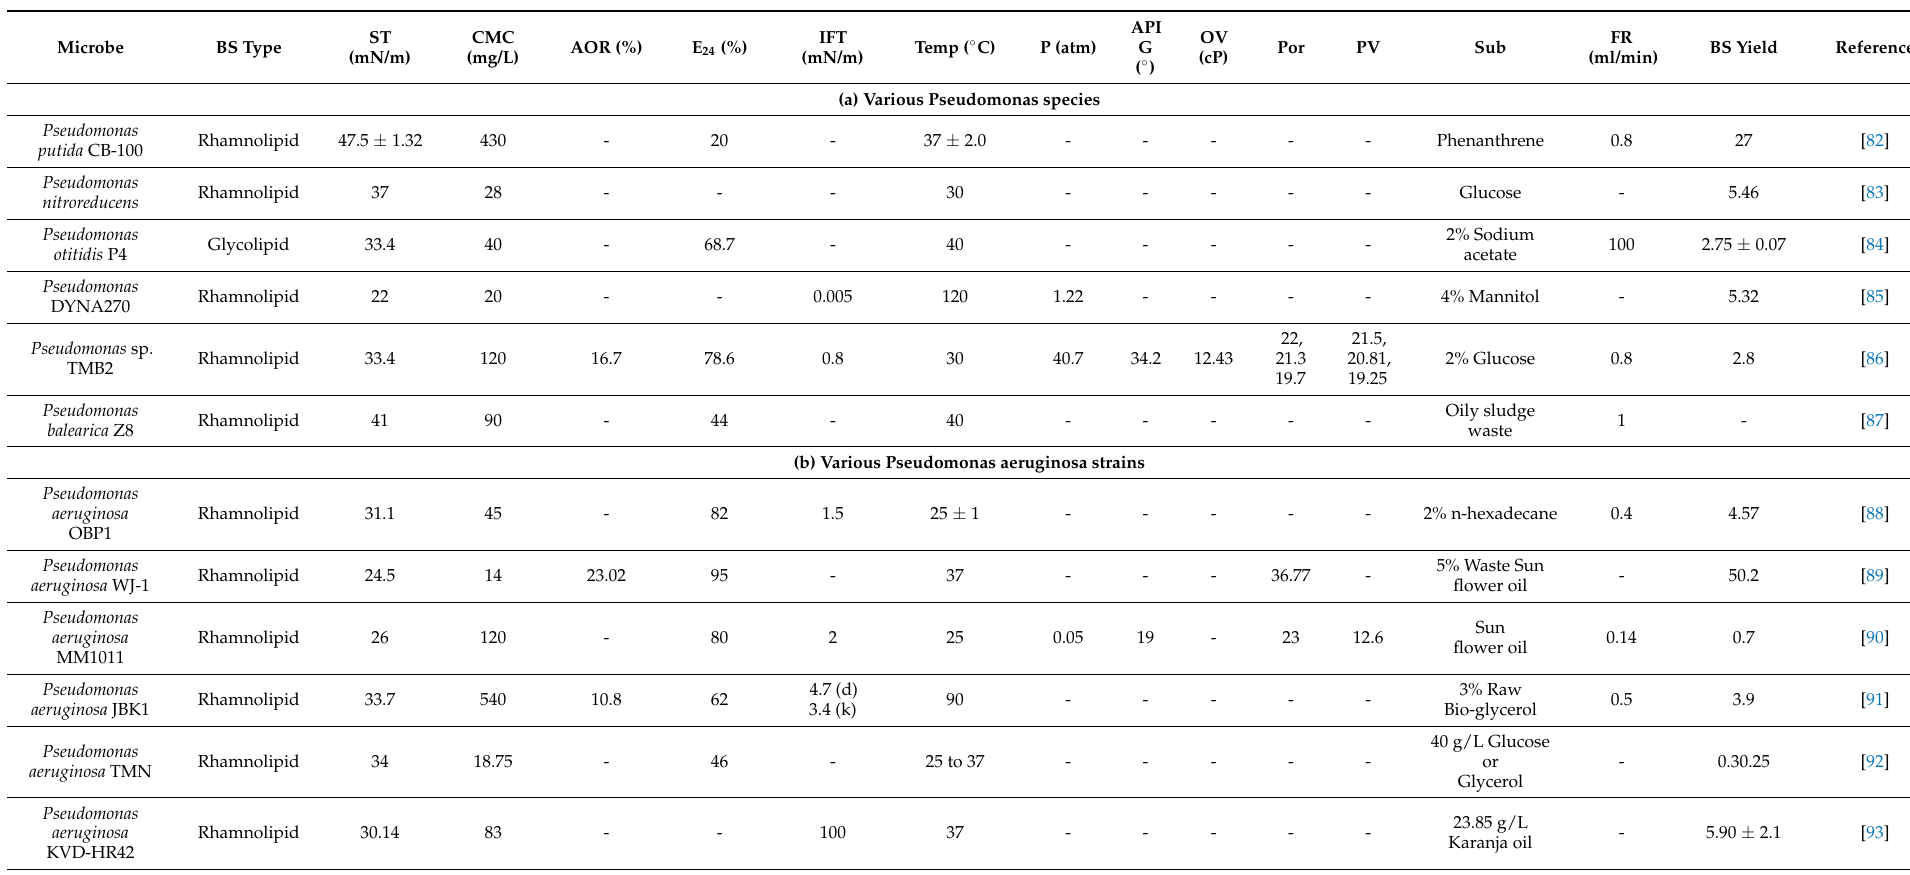
Table 2. Properties of biosurfactants produced by various microorganisms of several strains. Abbreviations—BS: Biosurfactant, ST: Surface tension, CMC: Critical Micelle Concentration, AOR: Additional oil recovery, E 24 : Emulsification Index (mostly against kerosene, diesel, or sunflower oil), Temp: Temperature, P: Pressure, API G: American Petroleum Institute